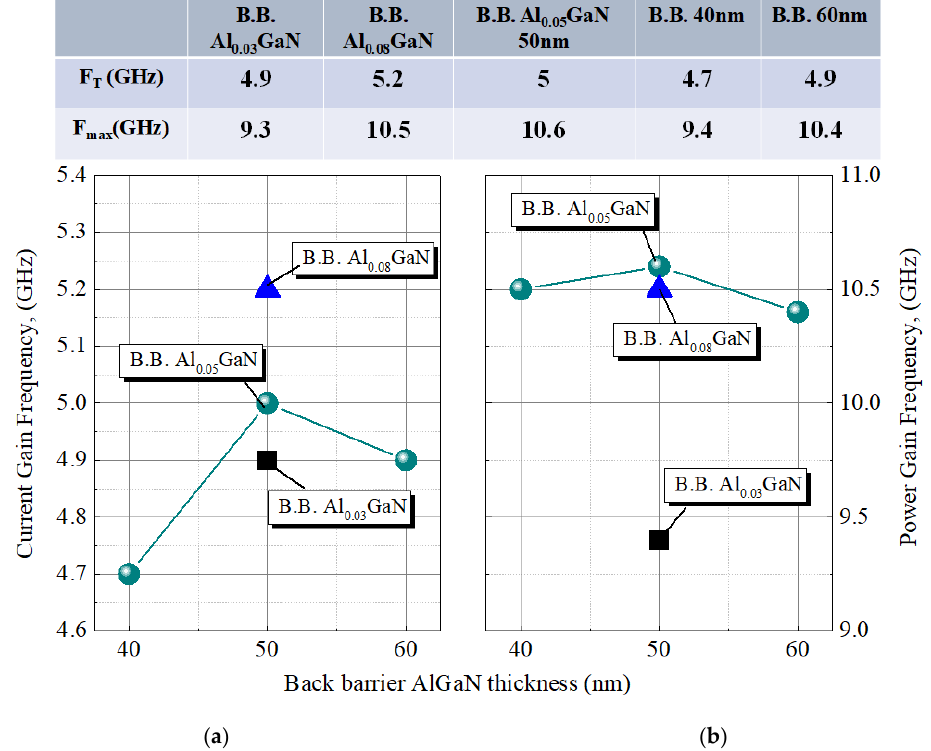
Figure 9. The current gain frequency (f T ) and power gain frequency (f max ) of devices. ( a ) the different Al mole fraction; ( b ) the different thickness of B.B. devices. mole fraction; ( b ) the di ff erent thickness of B.B.